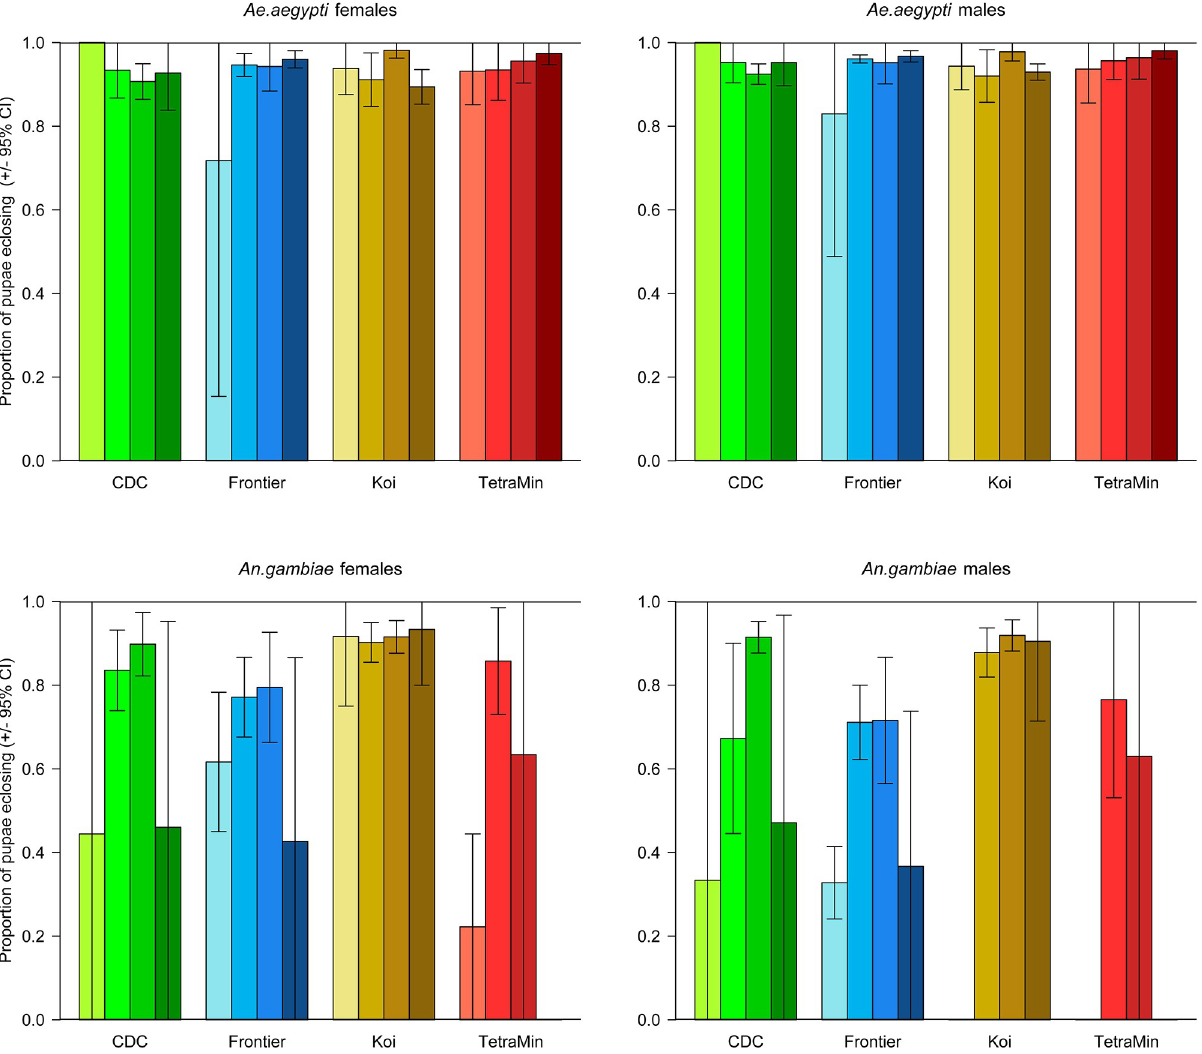
Fig 3. Eclosion of pupae that formed by diet type and level. Error bars represent the 95% CI. Darkening shades of color represent the increasing diet levels of 8, 16, 32 and 64 mg.